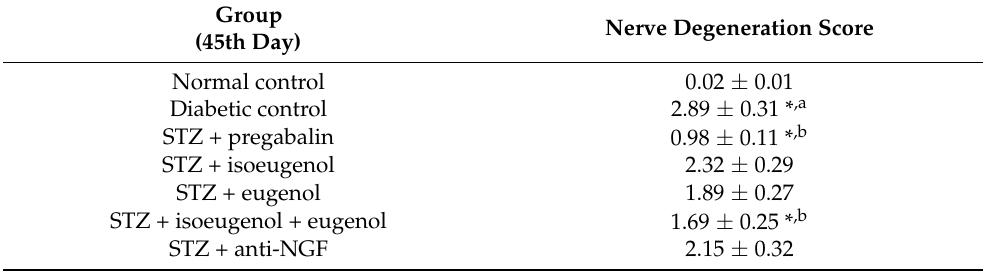
Table 3. Histologic score of sciatic nerve lesions in different